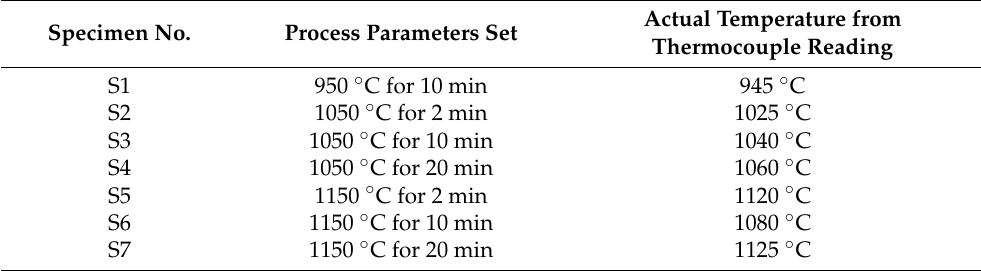
Table 2. Seven parameter combinations investigated in this